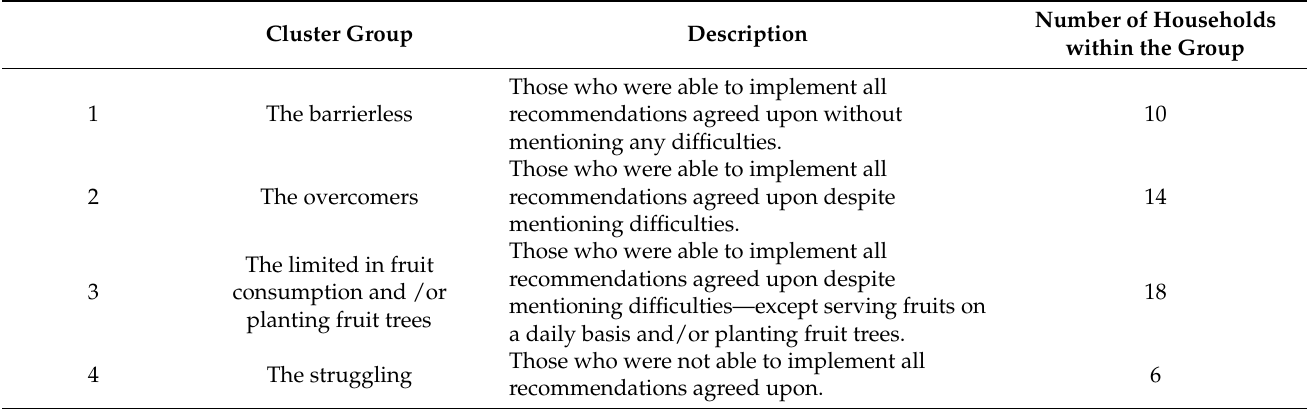
Table 4. Description of the different cluster groups and number of households within each group. Cluster Group Description